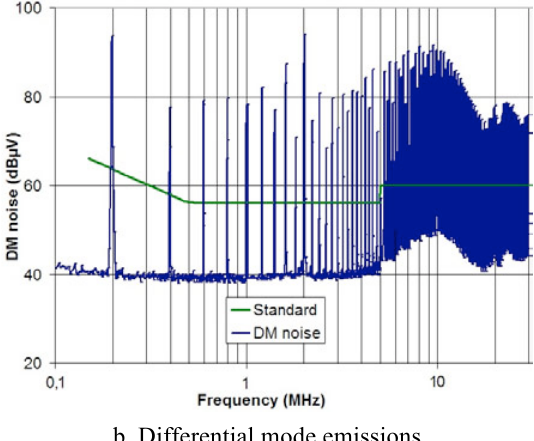
Figure 5: The spectrum of the CM and DM currents To design of the L-C structure filter, the slopes of ± 40dB/decade are drawn to determine the cutoff , f and f , f . The frequencies for each mode: f CM CMH DM DMH filter elements are calculated from these cutoff frequencies as shown in Figure 6. As presented in [13], frequencies parasitic elements of passive